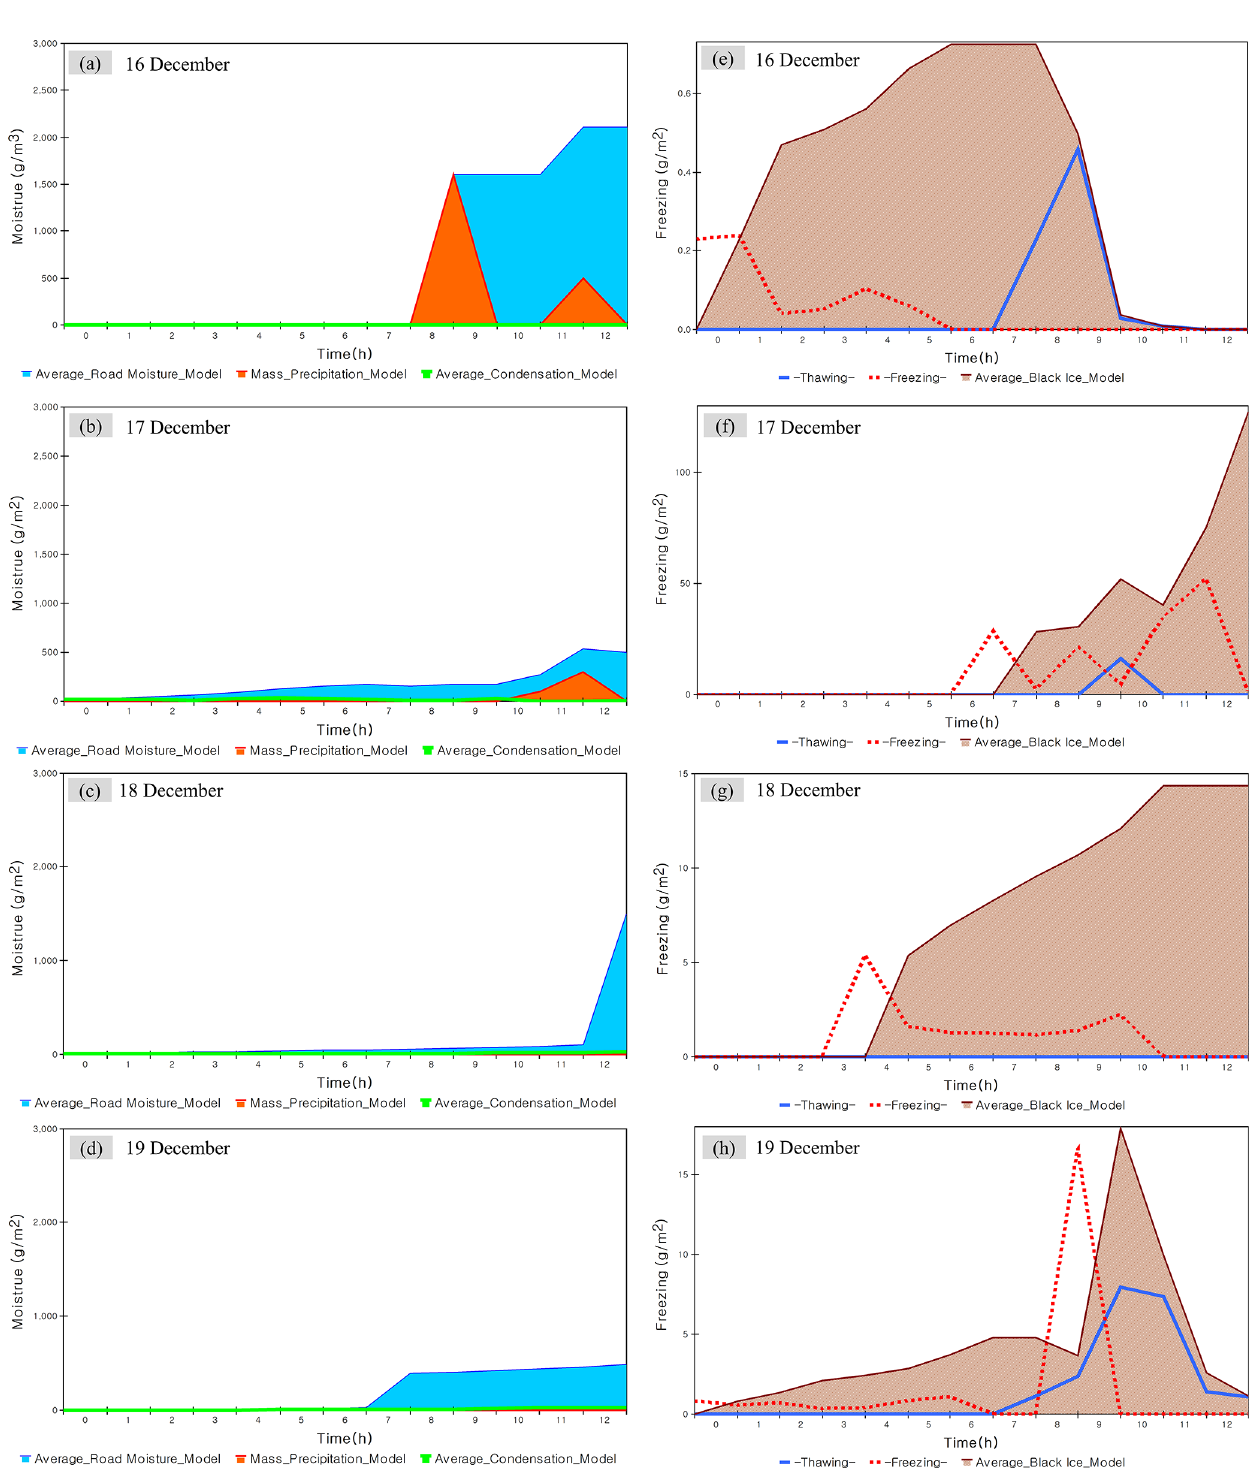
Figure 8. Prediction of road moisture and black ice through system dynamics model. Panels (a–d) are the road moisture (calculated by condensation and precipitation) per hour on the road from 16–19 December. Panels (d–g) are black ice (calculated by freezing, thawing) per hour on the road from 16–19